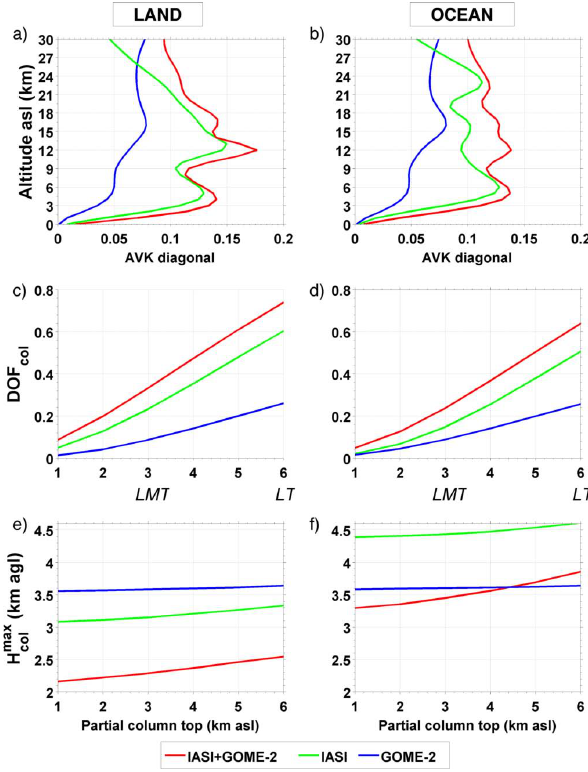
Fig. 2. Fitting residuals (in %) of IASI+GOME-2 in the (a) TIR and (b) Huggins UV bands over Europe on 19 August 2009. (c) Quality flags for IASI+GOME-2 retrievals (0 indicates Planck function fil- ter, 1 indicates cloud fractions>0.3, 2 indicates surface temperature residuals>0.7%, 3 indicates ozone residuals>0.7% and 4 indicates retrieved ozone<0.1ppb or retrieved surface temperature<274 K).